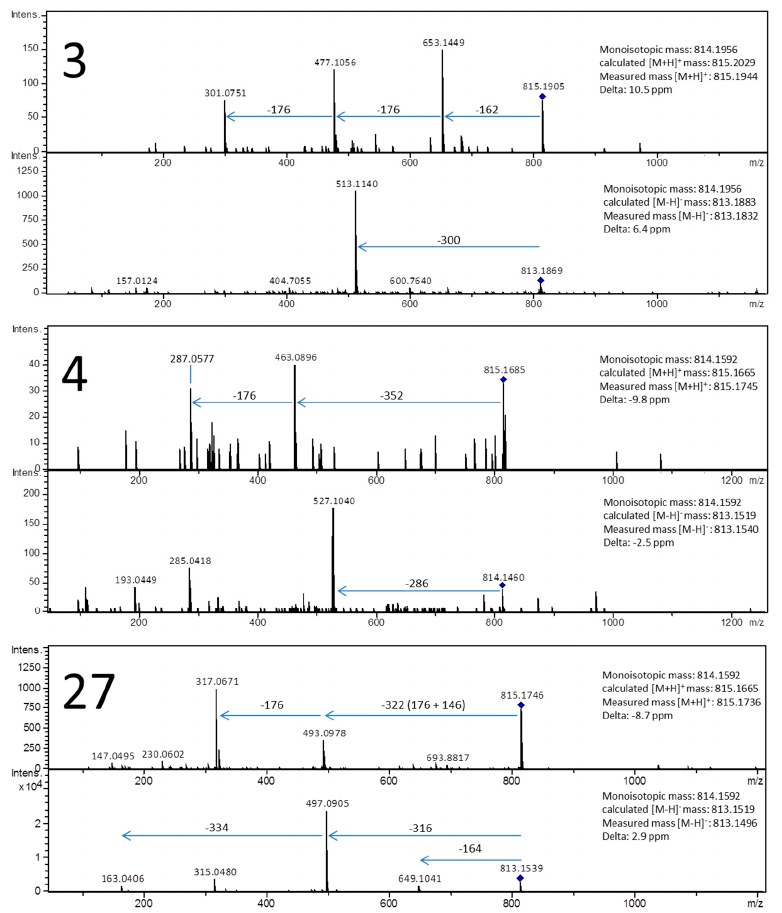
Figure 3. Mass spectra registered in positive and negative ion mode for isomeric and isobaric compounds: chrysoeriol 7- O -[2- O -feruloyl-glucuronopyranosyl-(1-3)- O -glucopyranoside] ( 3 ), luteolin 7- O -[2 ′ - O -feruloyl-glucuronopyranosyl-(1-2)- O -glucuronopyranoside] ( 4 ) and isorhamnetin 3- O -[2 ′ - O -coumaroyl-glucuronopyranosyl-(1-2)- O -glucuronopyranoside] ( 27 ).